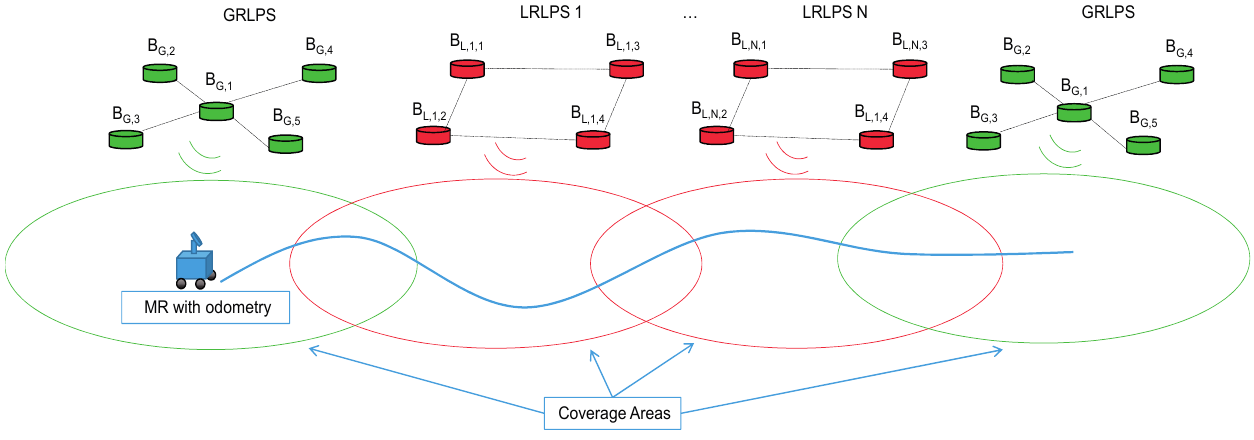
Figure 1. Particular case of globally-referenced LPS (GRLPS) and locally-referenced LPS (LRLPS) structures, with five and four beacons, respectively. MR, mobile